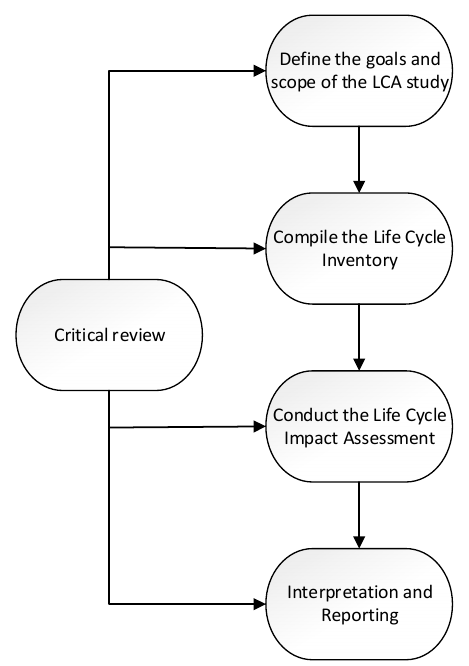
Figure 1. Phases of a Life Cycle Analysis (LCA) study (based on ISO 14040:2006).